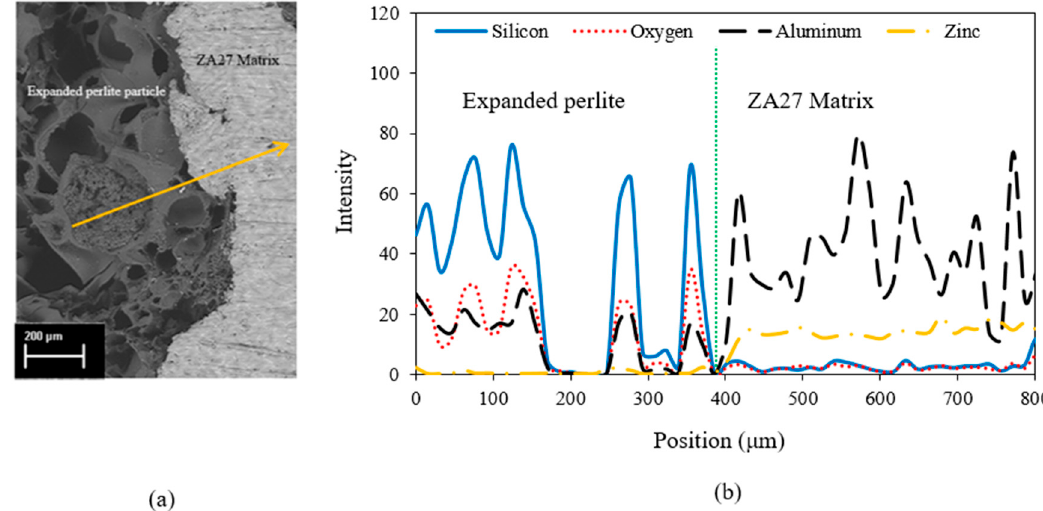
Figure 3. ( a ) SEM image of the interface between expanded perlite particle and ZA27 matrix. ( b ) Energy dispersive spectroscopy (EDS) line scan along the arrow in (a).